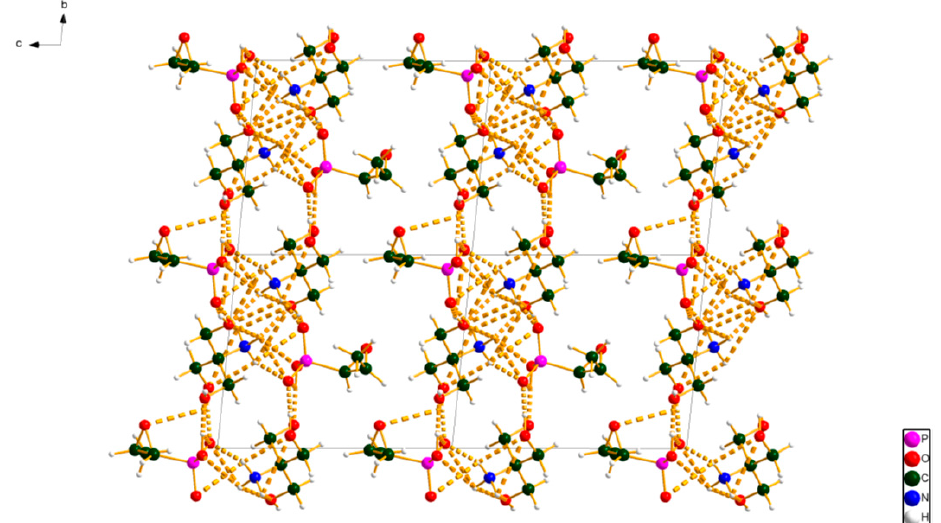
Figure 5. The crystal structure of fosfomycin tromethamine viewed down the a -axis.